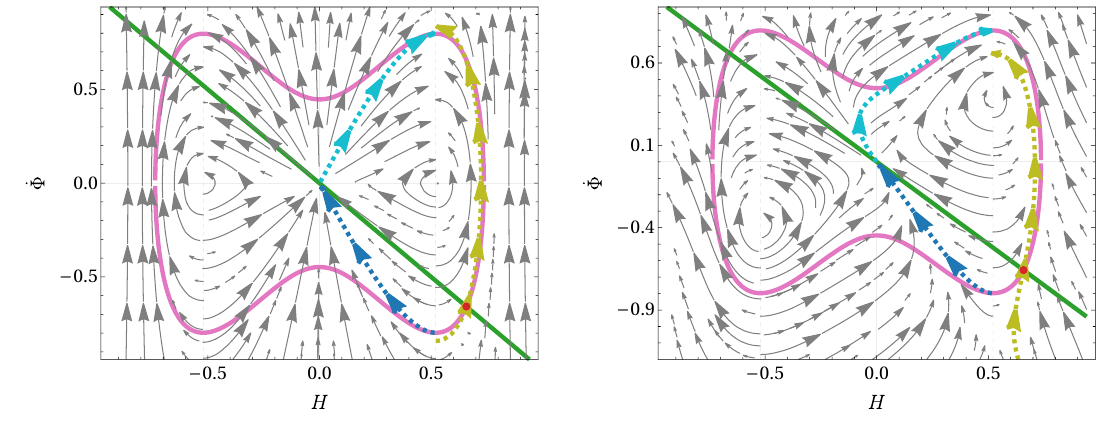
Figure 2 . Same plots as figure 1, except now for w = 0 and λ = 2 (left plot) and w = 1 and λ = 0 (right